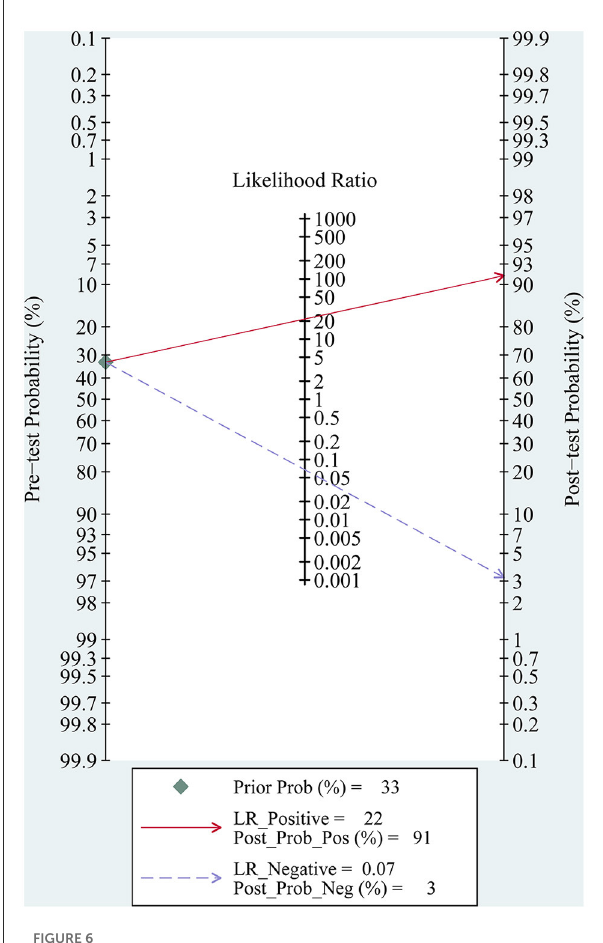
FIGURE6 Fagan nomogram of the accuracy of AI in the diagnosis of